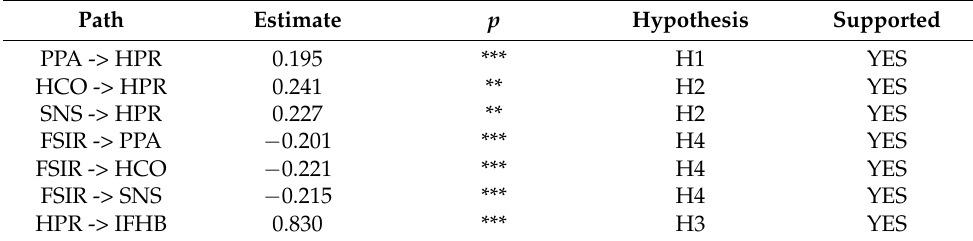
Table 8. Detailed results of the structural equation.